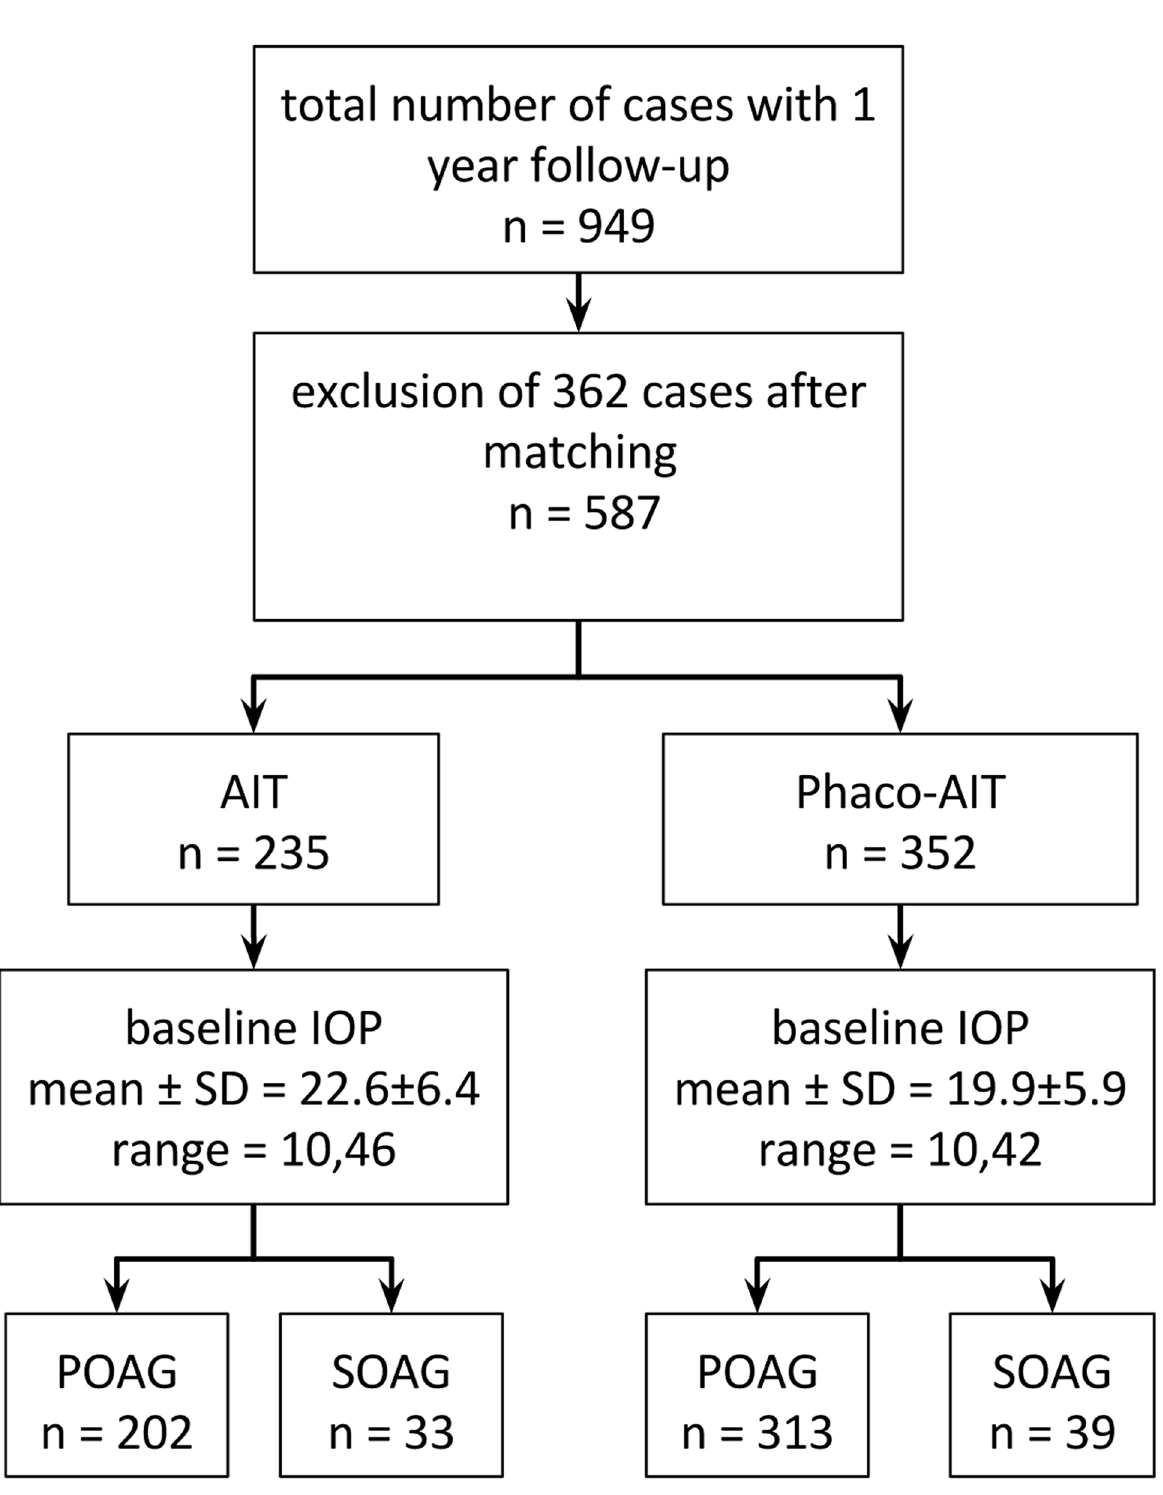
Fig 1. Trabectome Surgeries. Cases analyzed after accounting for exclusion criteria (AIT, ab interno trabeculectomy; phaco-AIT, AIT combined with phacoemulsification; IOP, intraocular pressure; POAG, primary open angle glaucoma; SOAG, secondary open angle glaucoma).